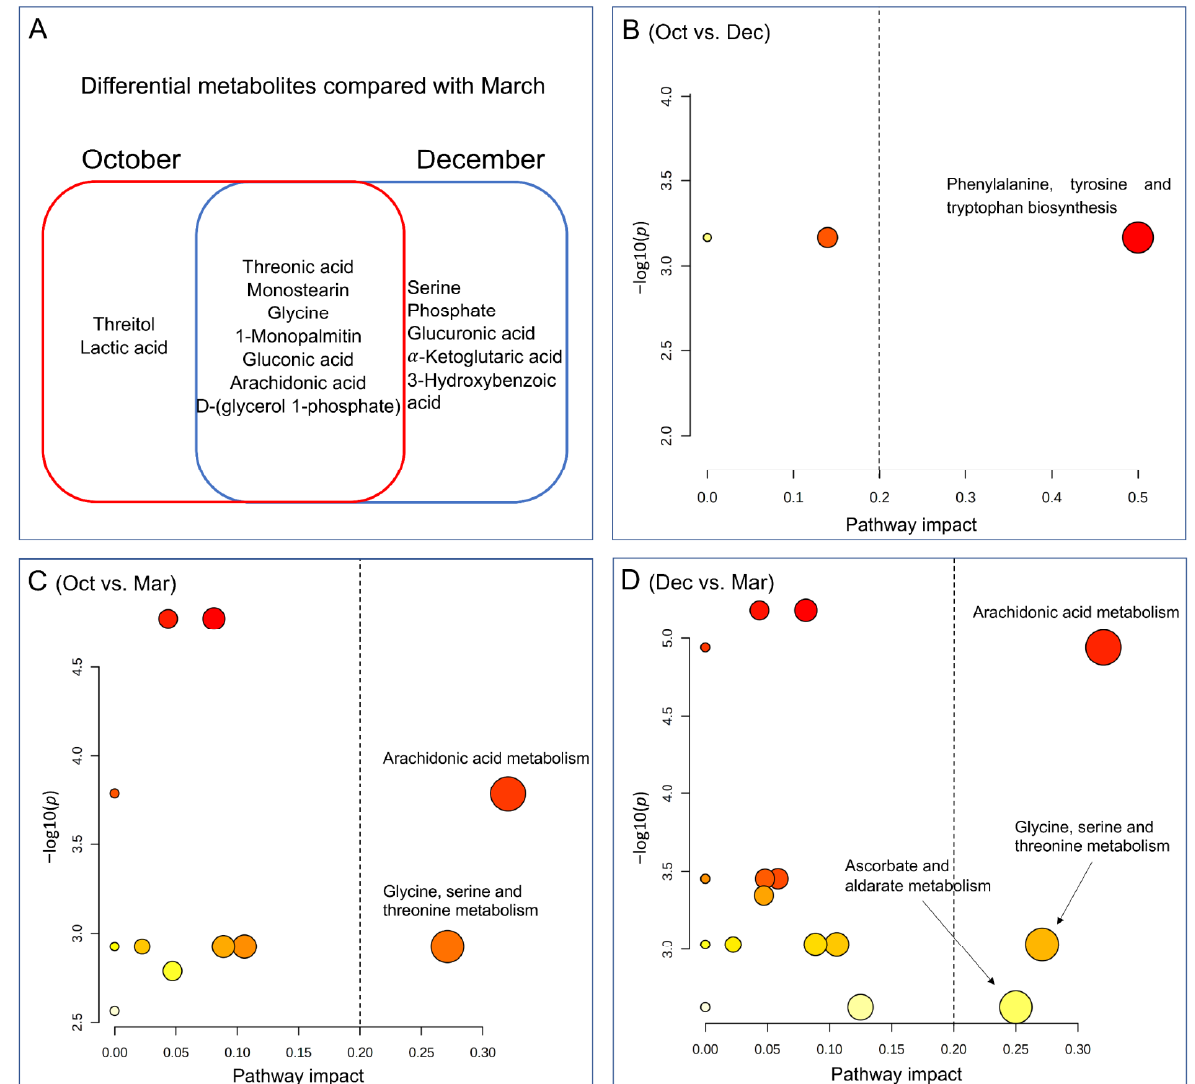
Figure 3. ( A ) summary of the differential serum metabolites in October or December compared with March; pathway impact analysis based on the differential serum metabolites between ( B ) October and December; ( C ) October and March; ( D ) December and March. Pathway impact > 0.20 and false discovery rate (FDR) < 0.05 were deemed as the key enriched pathways.